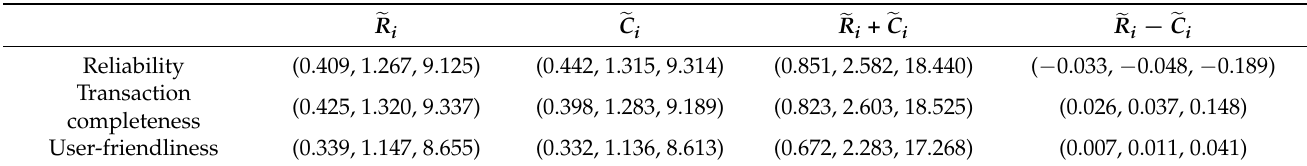
def def and ( (cid:101) R i − (cid:101) C i ) impacts using the three criteria of the technolog-